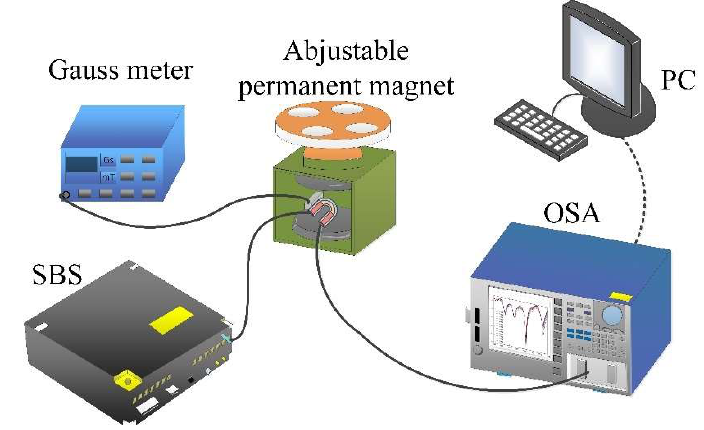
Figure 2. Experimental setup of the magnetic field measurement.